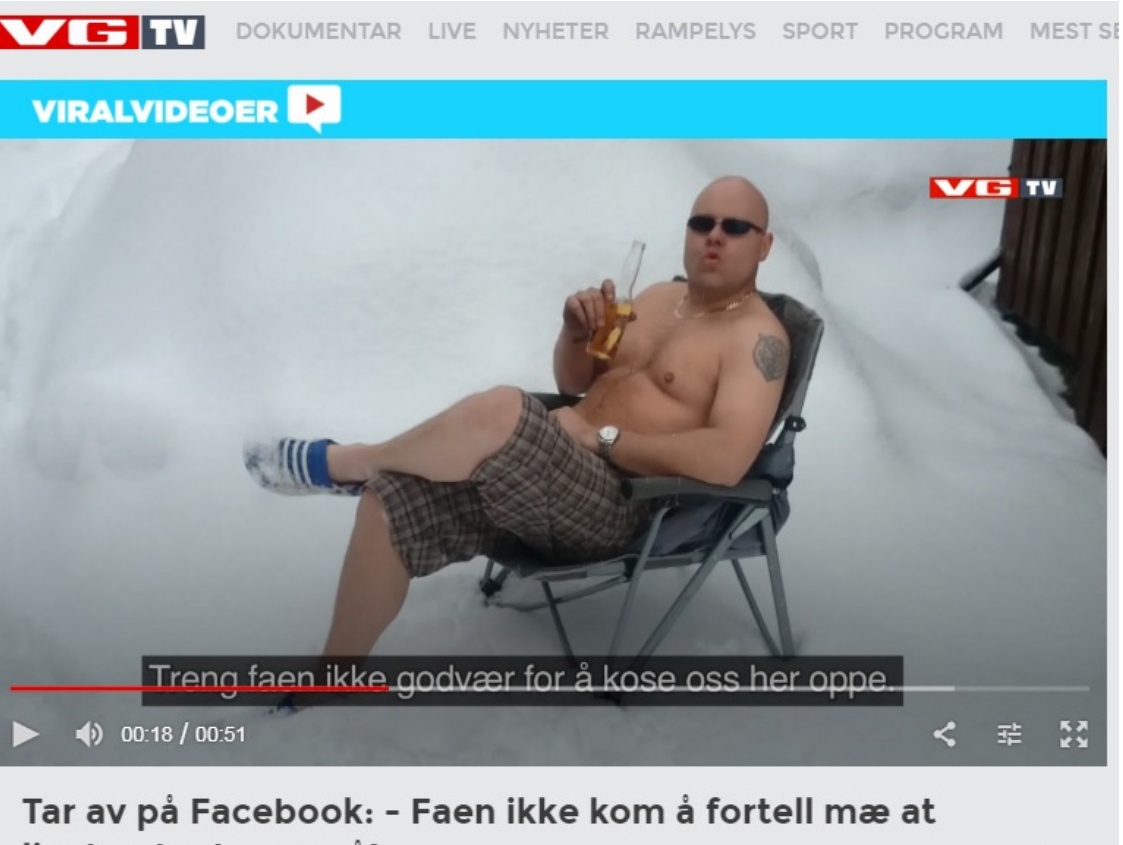
Figure 3. Humor and curiosa: sunbathing in the snow.